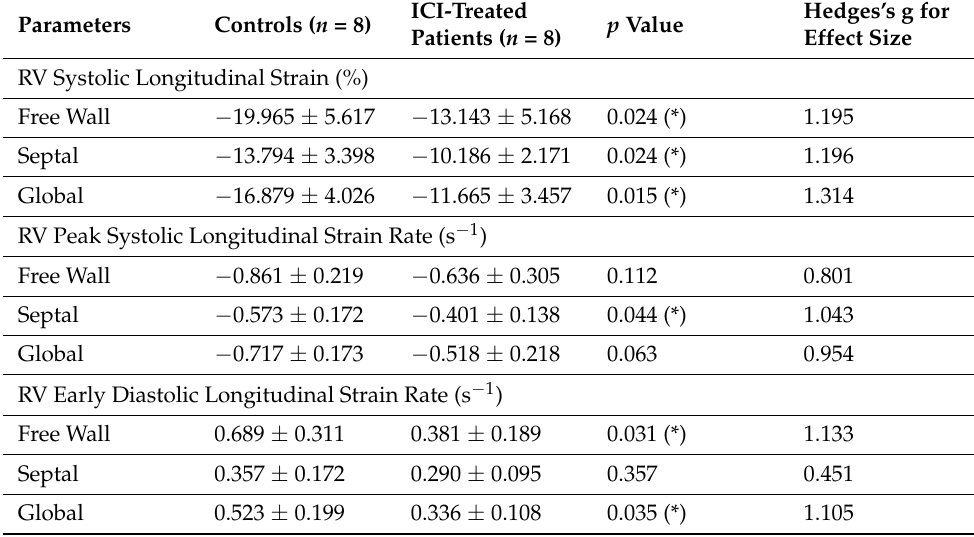
Table 8. Right ventricular (RV) strain and strain rate characteristics of immune checkpoint inhibitor (ICI)-treated patients compared to the controls using cardiac MRI.